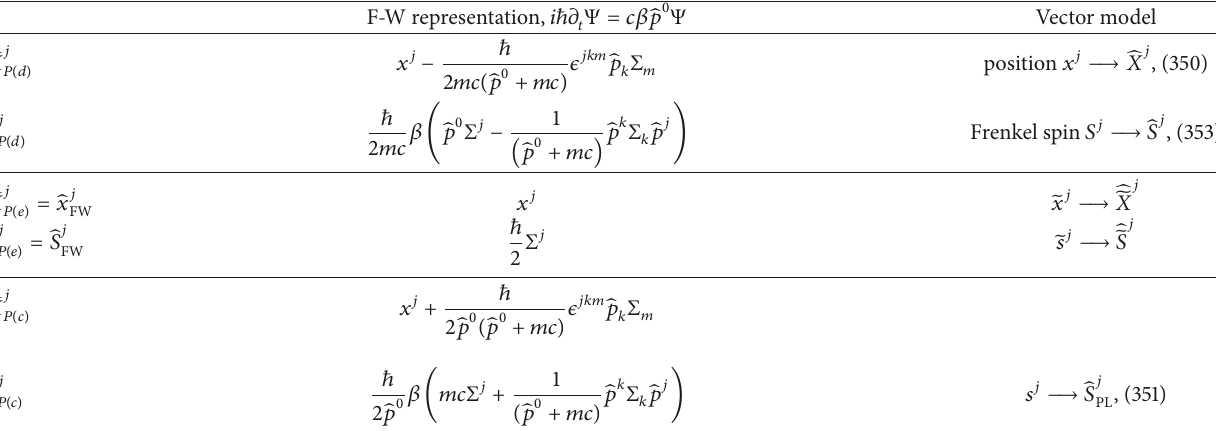
Table 4: Position/spin operators for the relativistic electron [75]. 𝛽 = ( 1 0 0 −1 ) , Σ 푖 = ( 휎 F-W representation, 𝑖ℏ𝜕 푡 Ψ = 𝑐𝛽̂𝑝